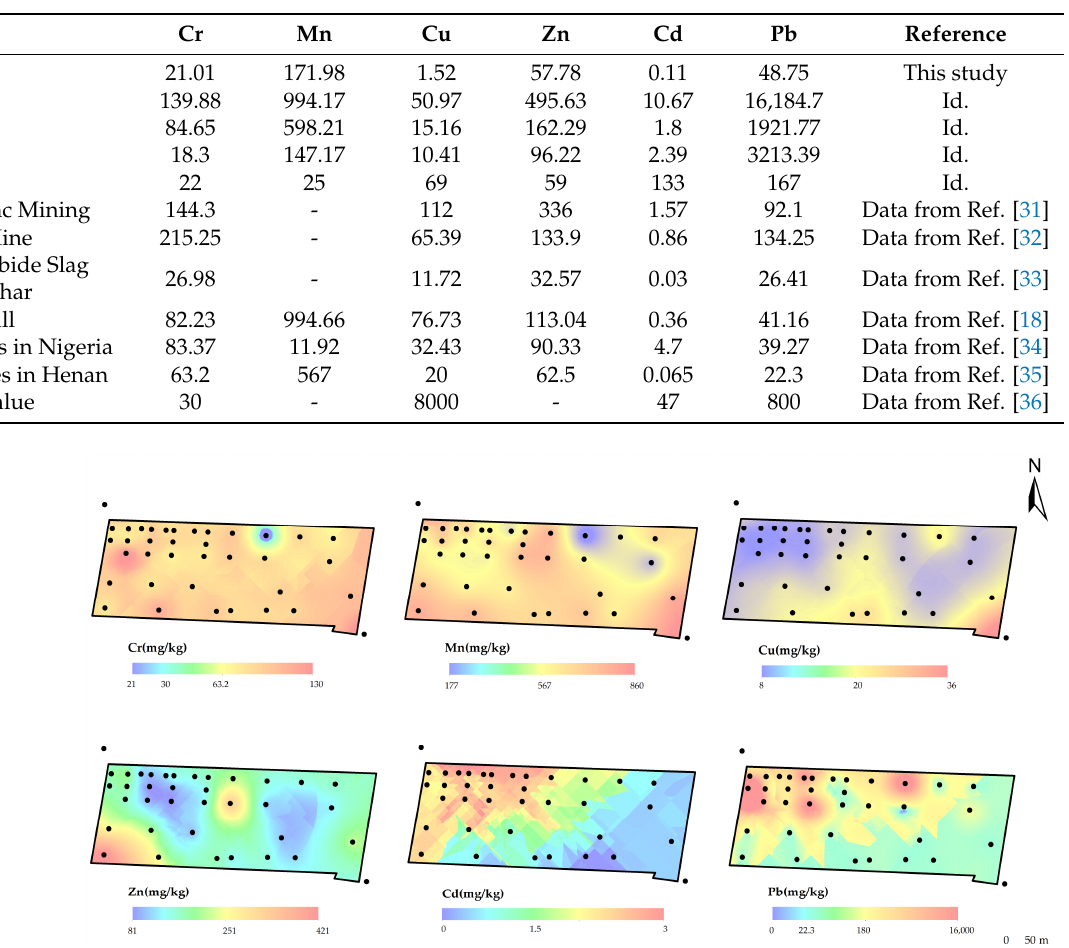
Table 5. HM concentrations of surface soil and related site background values (mg/kg).